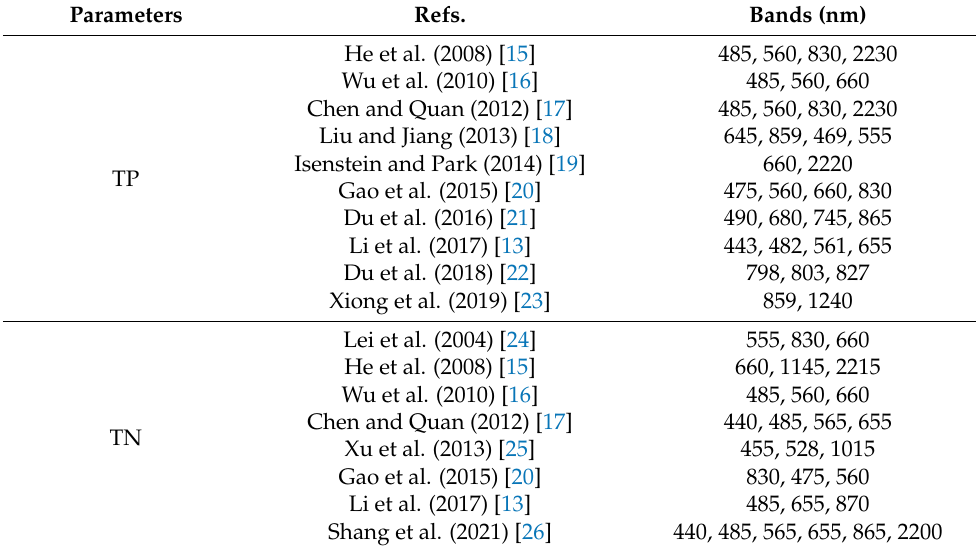
Table 1. Bands to estimate TP and TN